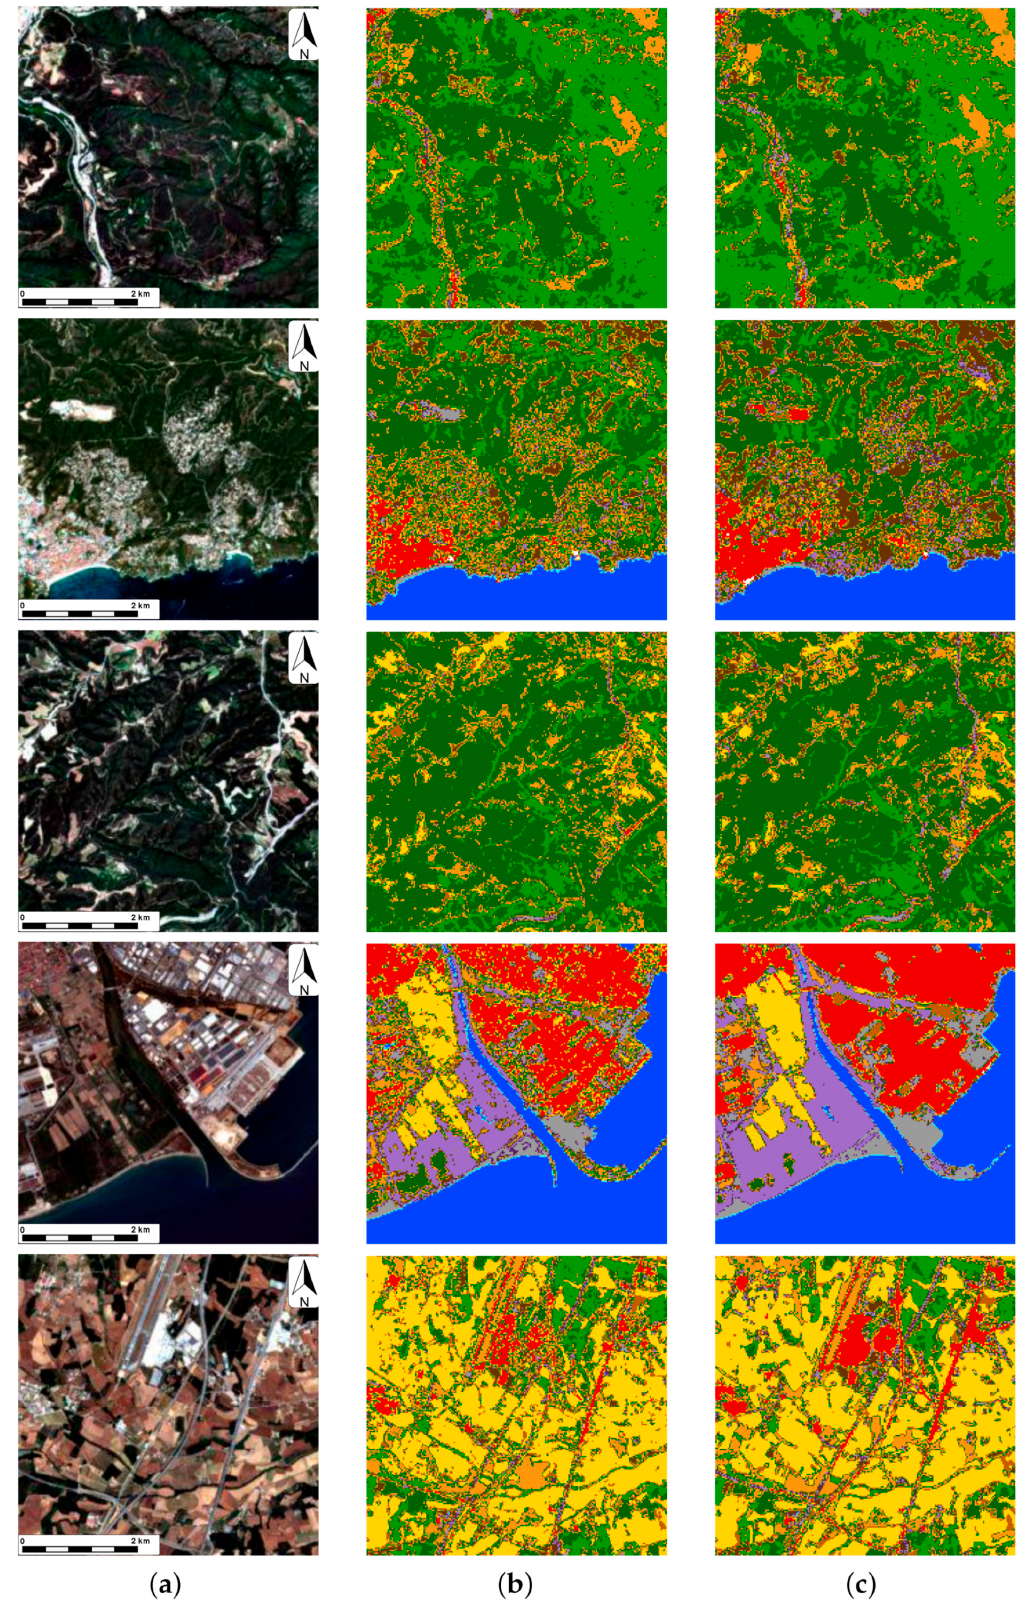
Figure 9. SSSR results obtained with model v 4 using Pixel Shuffle: ( a ) Sentinel-2 image (SISR ground truth), ( b ) ground truth, ( c ) SSSR semantic segmentation map. The colormap is the same as depicted in Figure